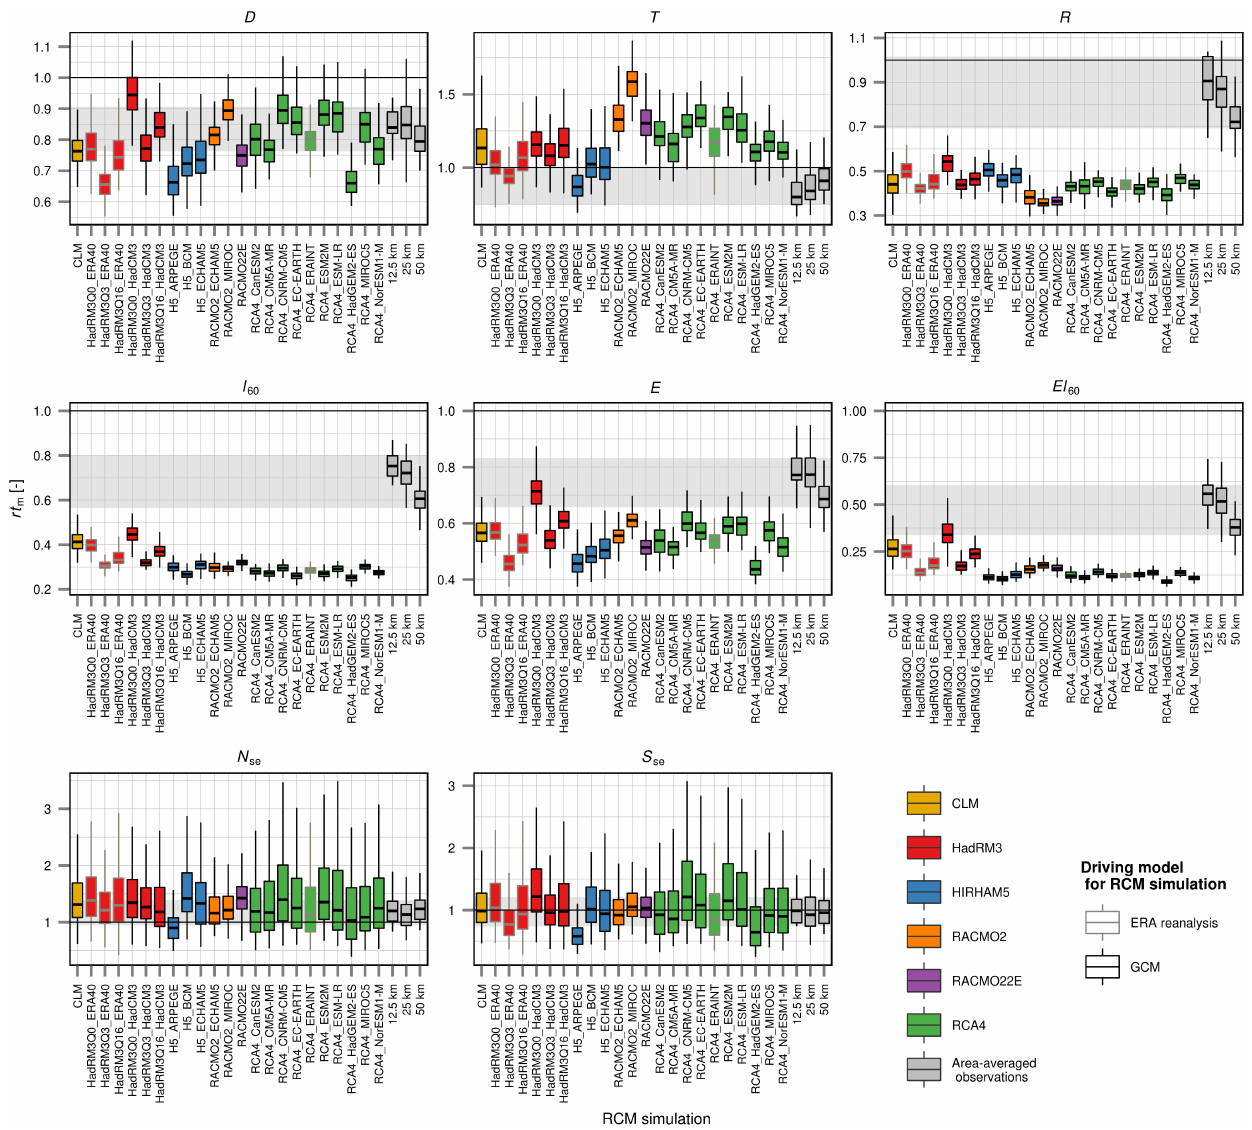
Figure 3. Ratios rt m between areal (grid box or neighbourhood) and station average of mean (event and seasonal) characteristics for each RCM simulation and area-average observations (grey box plots in the right part of each panel). Each box plot corresponds to values for all grid boxes (neighbourhoods) over the Czech Republic. Grey areas indicate the range between the minimum 25th and maximum 75th quantiles of rt m for observed data from all